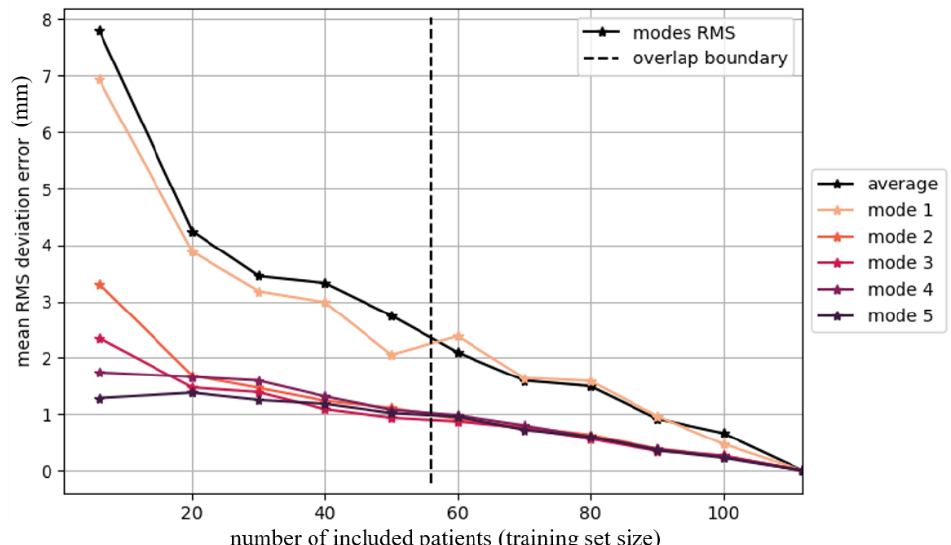
Figure 3. Mean RMS deviation between two Asian femur SSMs computed with different input data, for an increasing number of input patients (set size).